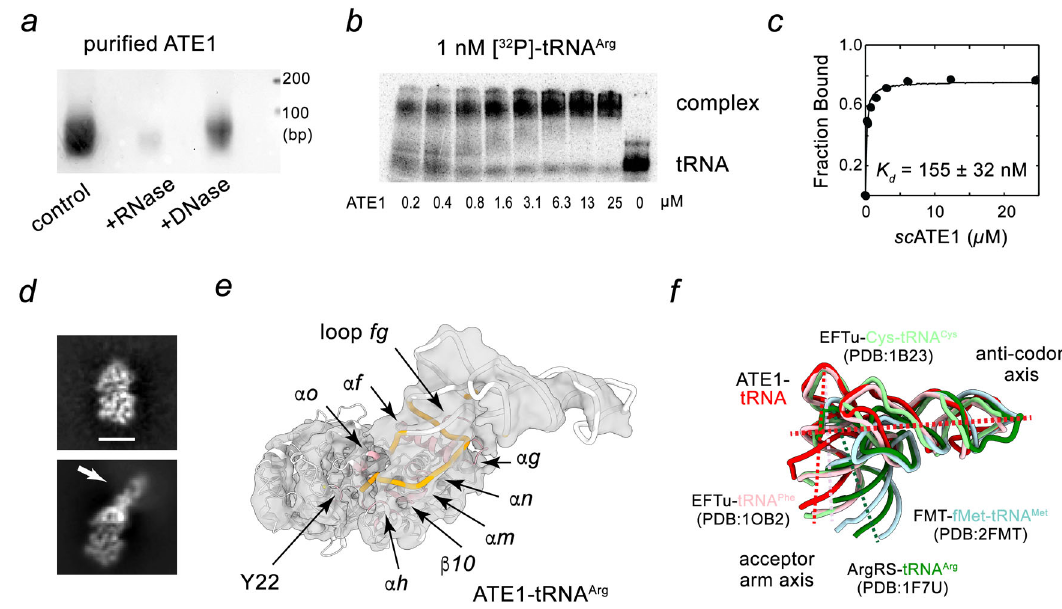
Fig. 3 | Interactions between sc ATE1 and tRNA. a Agarose gel electrophoresis of puri fi ed sc ATE1protein sample with or withoutDNase or RNase treatment. Atleast three independent experiments were performed with similar results. b EMSA visualization and c quanti fi cation of ATE1 binding to in vitro transcribed tRNA Arg labeledwith 32 P. d Representative2DclassaveragesofATE1particles(top)andATE1 with density features indicative of bound nucleic acid (bottom; highlighted with arrow). Scale bar is 50Å. e CryoEM structure of sc ATE1-tRNA complex.